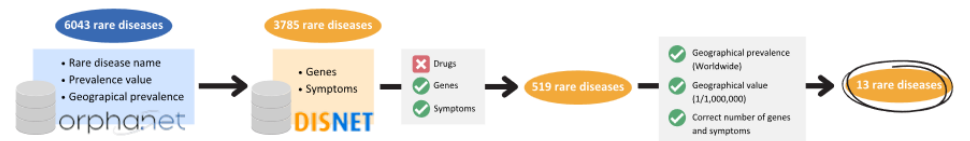
Figure 2. Workflow followed to choose 13 rare diseases to be studied.